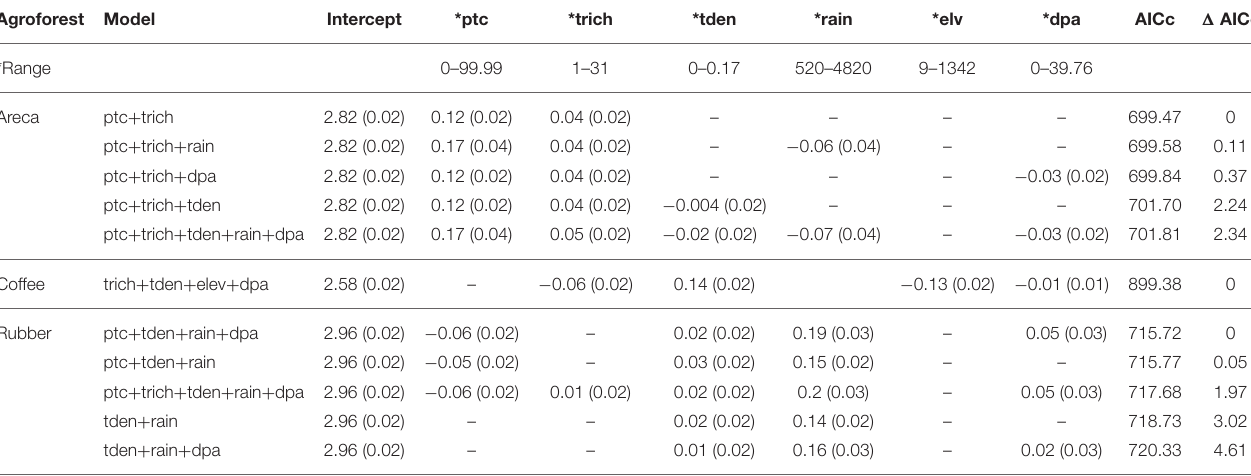
TABLE 2 | Influence of predictors on species richness (Beta co-efficients of top models and associated standard errors). Agroforest